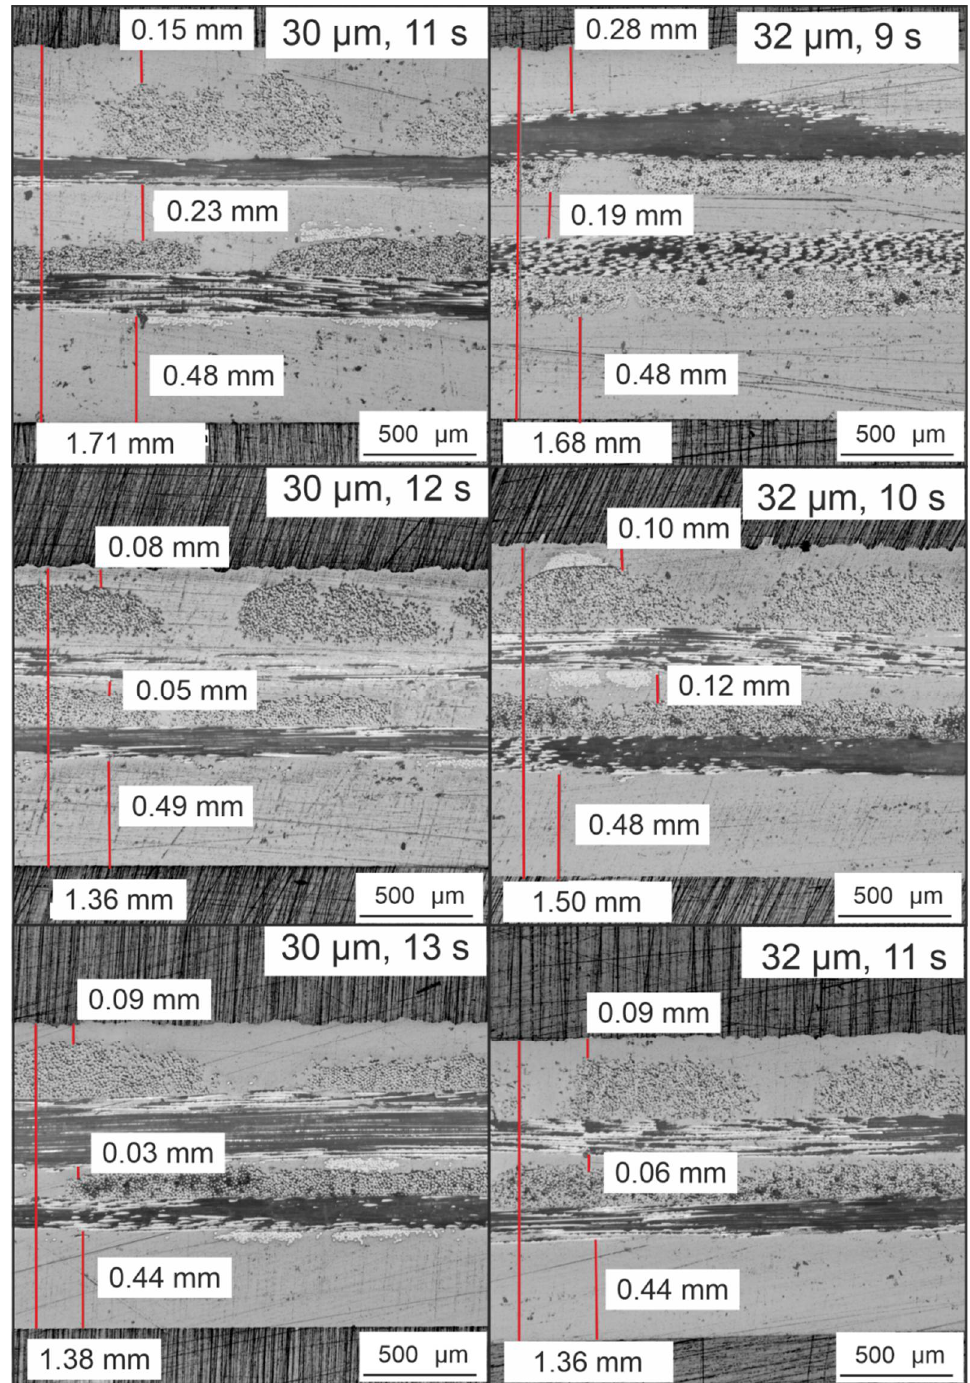
Figure 7. Microscopic images of 5-layer setup with different impregnation parameters.